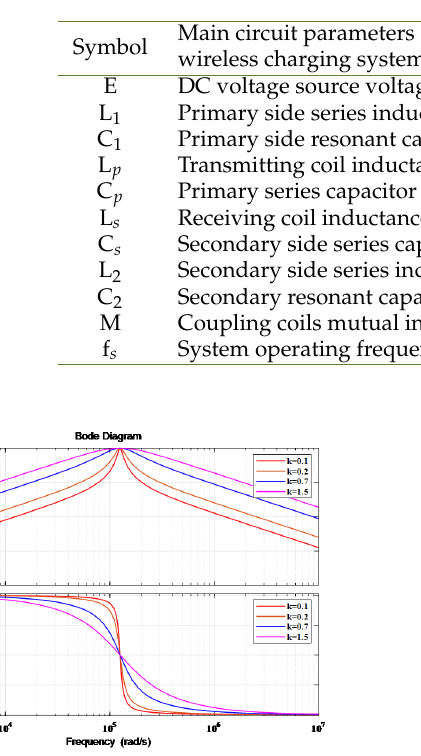
Table 3. Simulation model parameters